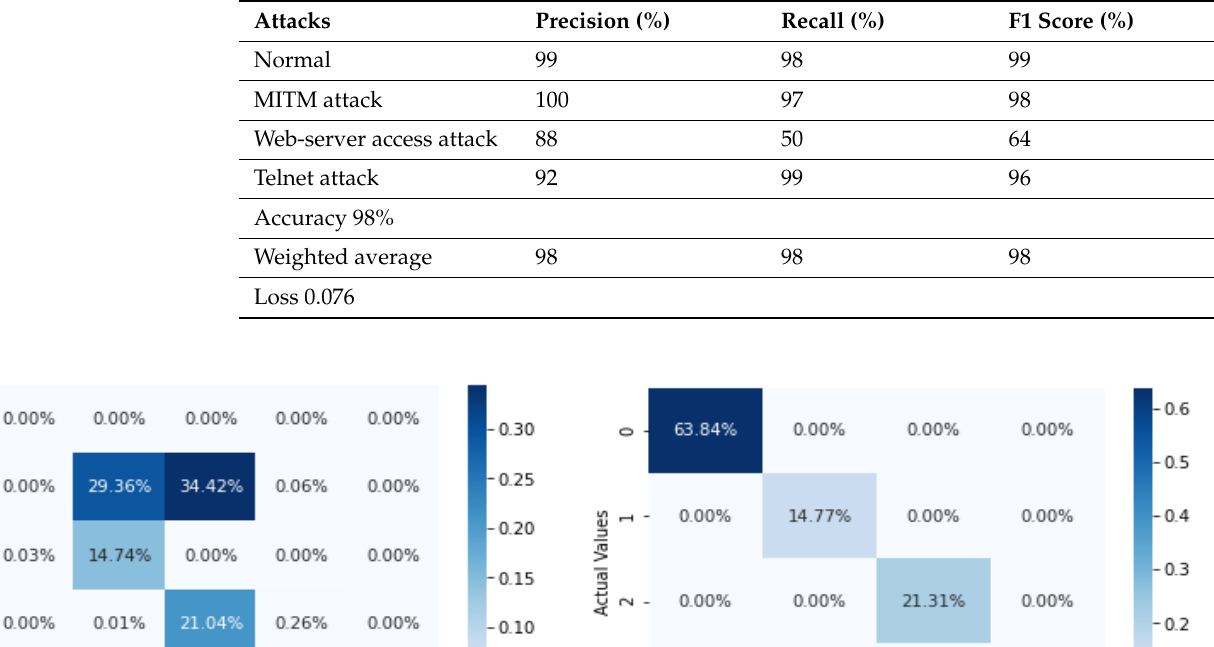
Table 12. Results of the CNN-LSTM model using the multiclass classification dataset.